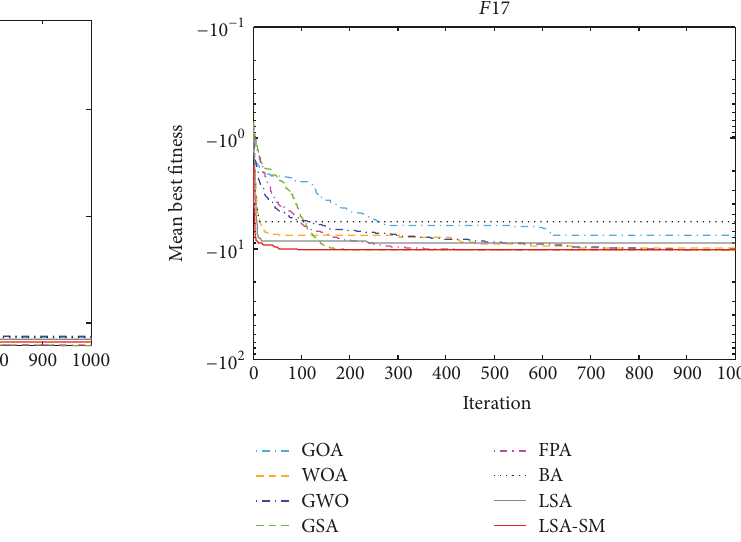
Figure 19: 𝐷 = 6 , convergence curves for 𝑓 15 .